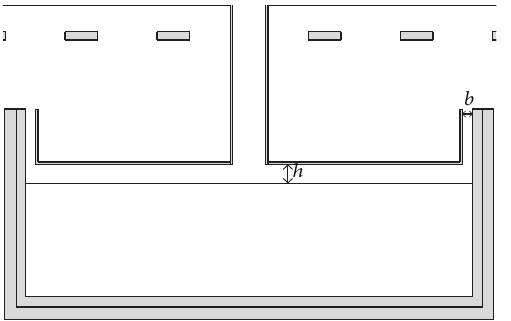
Figure 2: Design of the crucible U cover.